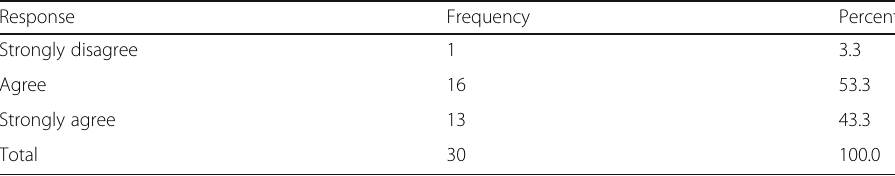
Table 12 Greater use of space-efficient packaging/handing equipment Response Frequency Strongly disagree Strongly